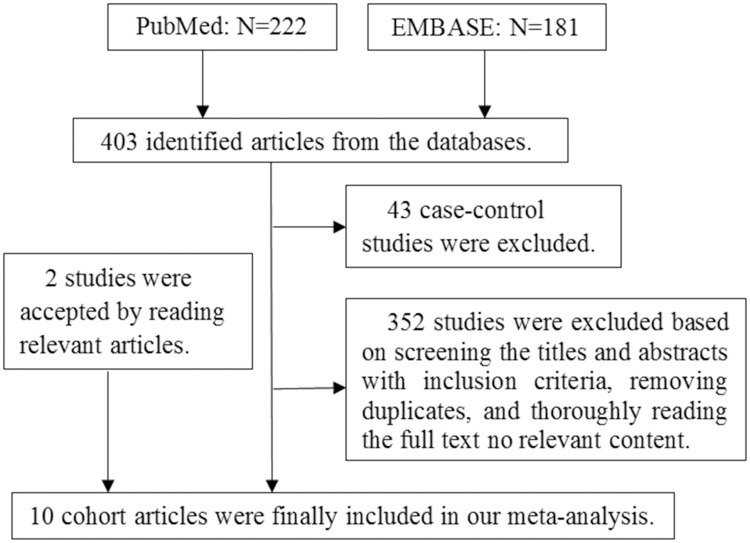
Flow chart illustrating the literature search for cohort studies on cholecystectomy in relation to CRC.Note: CRC represents colorectal cancer.